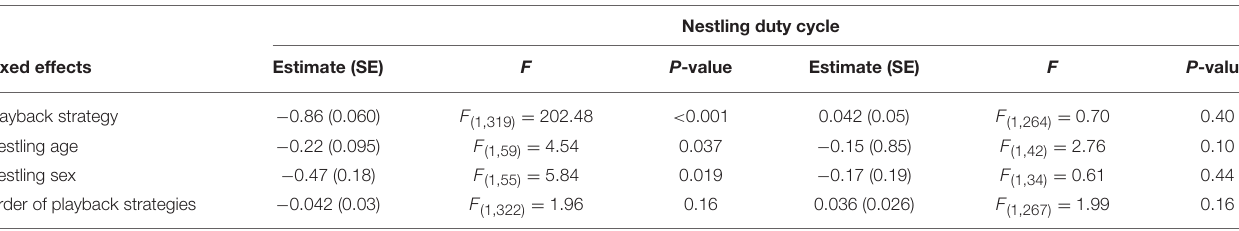
TABLE 4 | Effect of the playback strategies on the vocal duty cycle of nestling barn